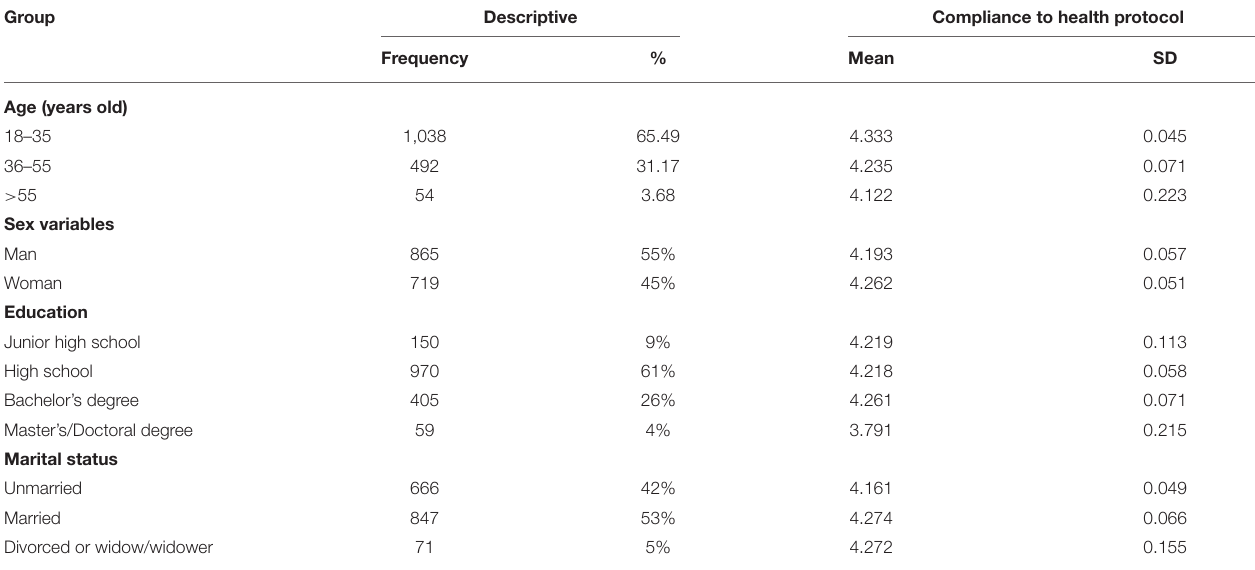
TABLE 1 | Demographic characteristics and difference in perceived compliance to health protocol among subjects ( n = 1,584).